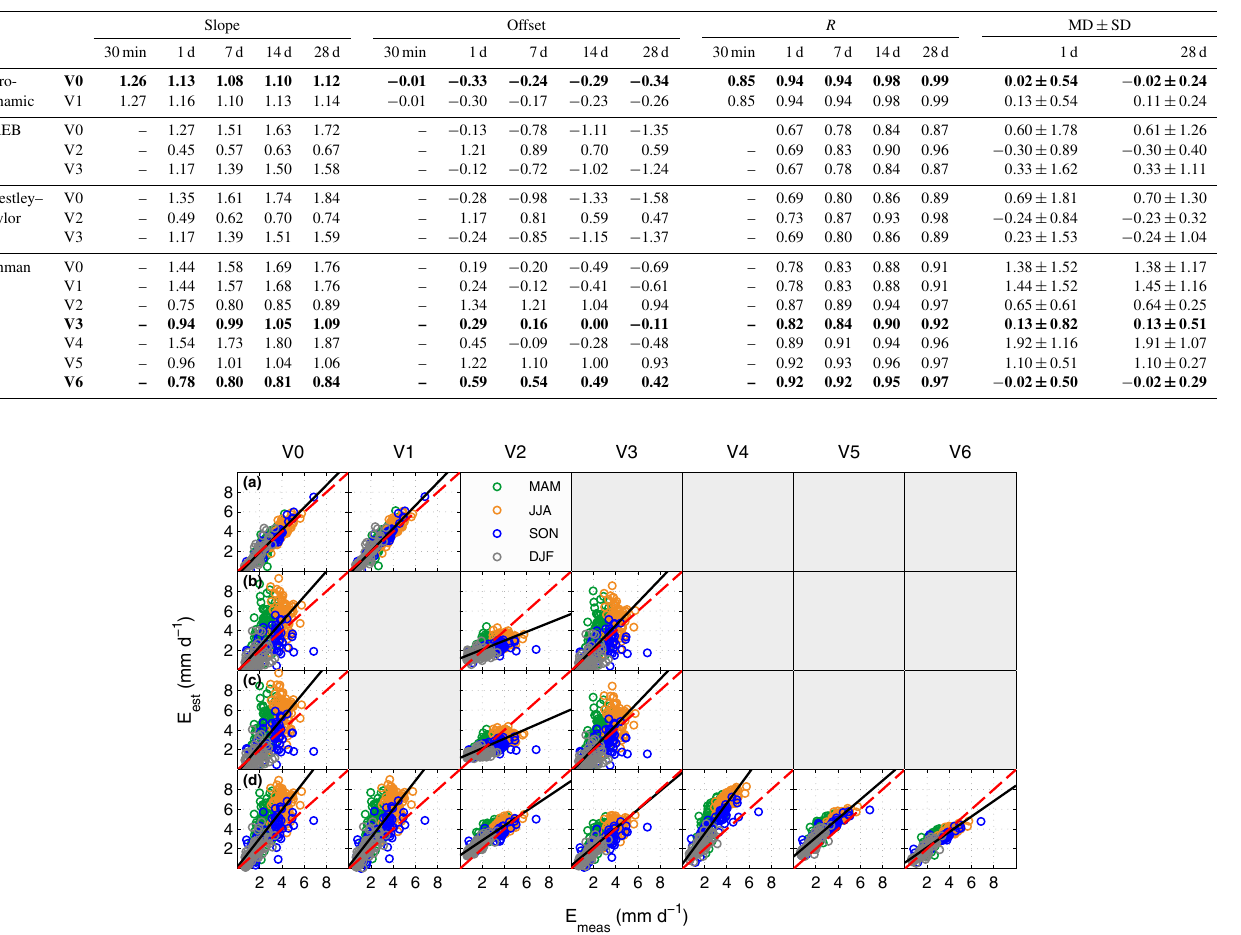
Figure 6. Correlation between estimated and measured daily evaporation rates for (a) the aerodynamic approach, (b) the BREB method, (c) the Priestley–Taylor equation, and (d) the Penman equation and their sensitivity studies (Table 2) calculated from 1d averages. The colours indicate the meteorological seasons spring (MAM), summer (JJA), autumn (SON), and winter (DJF). The regression line is shown in black and the 1 : 1 line as a dashed red